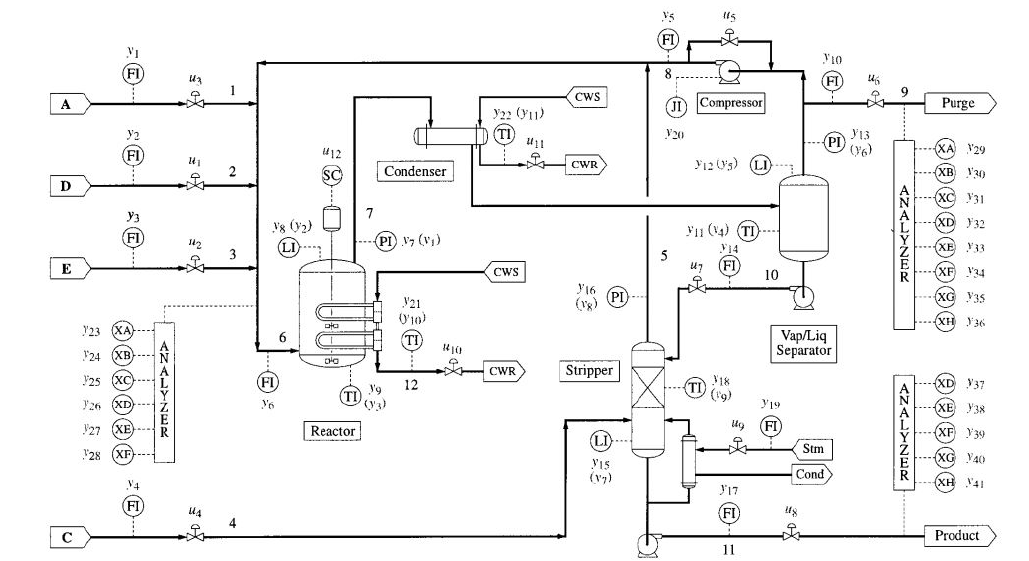
Figure 4. Schematic of Tennessee Eastman